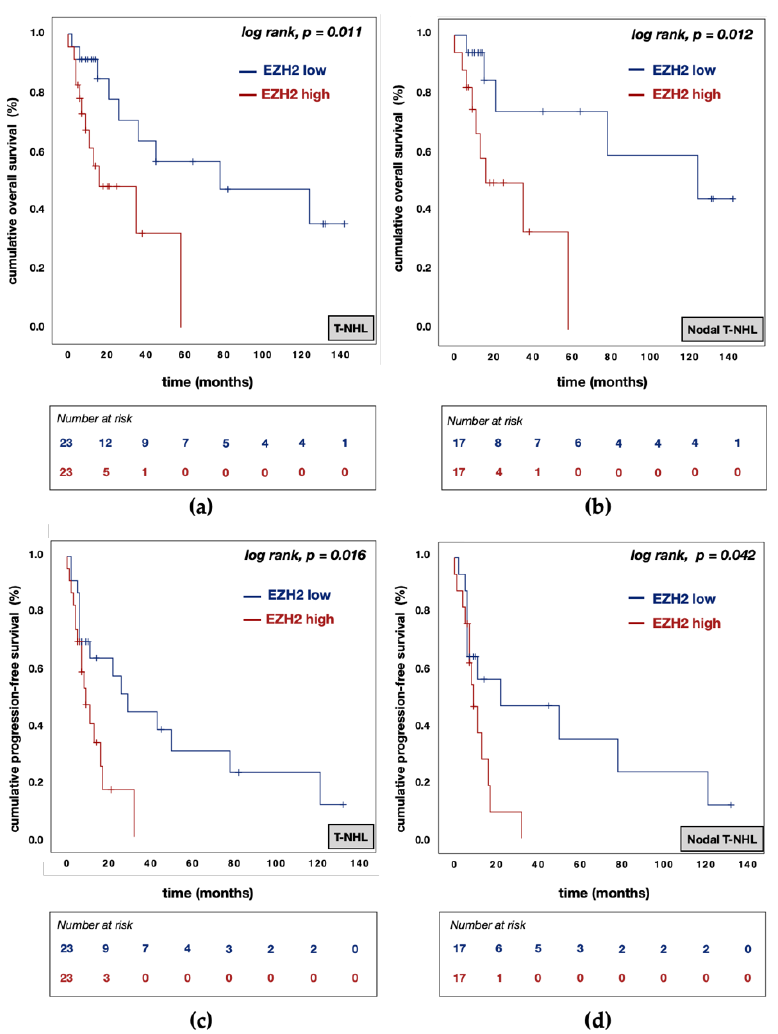
Figure 7. Kaplan–Meier (KM) curves for overall survival (OS) and progression-free survival (PFS) according to EZH2 protein expression. ( a ) KM curve for OS according to EZH2 protein expression in T-NHL; ( b ) KM curve for OS according to EZH2 protein expression in nodal T-NHL; ( c ) KM curve for PFS according to EZH2 protein expression in T-NHL; ( d ) KM curve for PFS according to EZH2 protein expression in nodal T-NHL. Abbreviations: T-NHL—T-cell non-Hodgkin’s lymphomas; EZH2 low —EZH2 protein expression with an H-score below 85; EZH2 high —EZH2 protein expression above or equal to an H-score of 85.